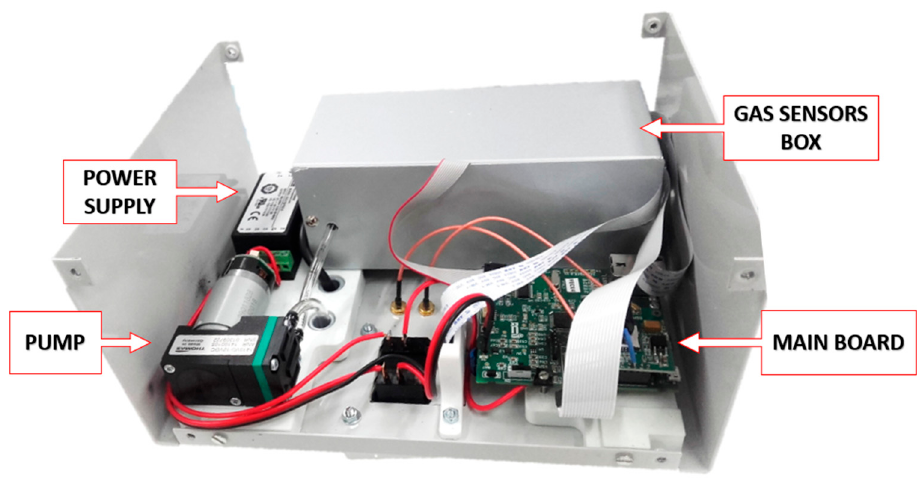
Figure 1. General diagram of the electronic design.